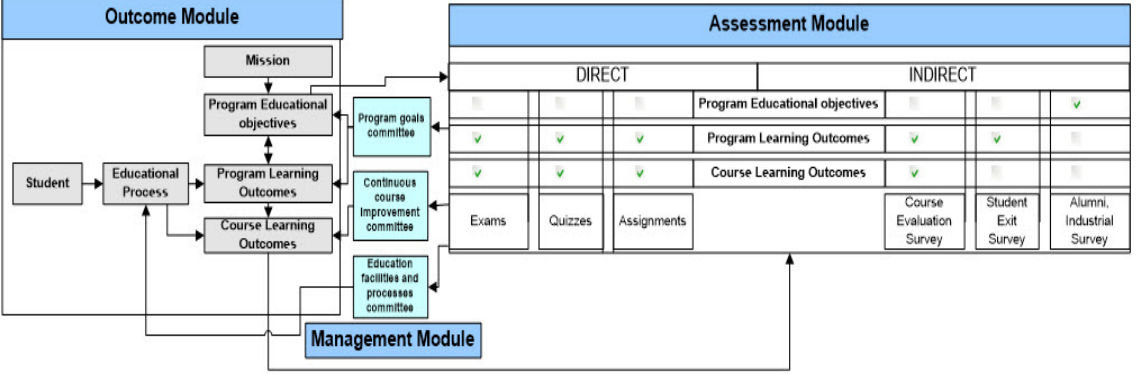
Figure 1. Outcomes Based Education Continuous Quality Improvement